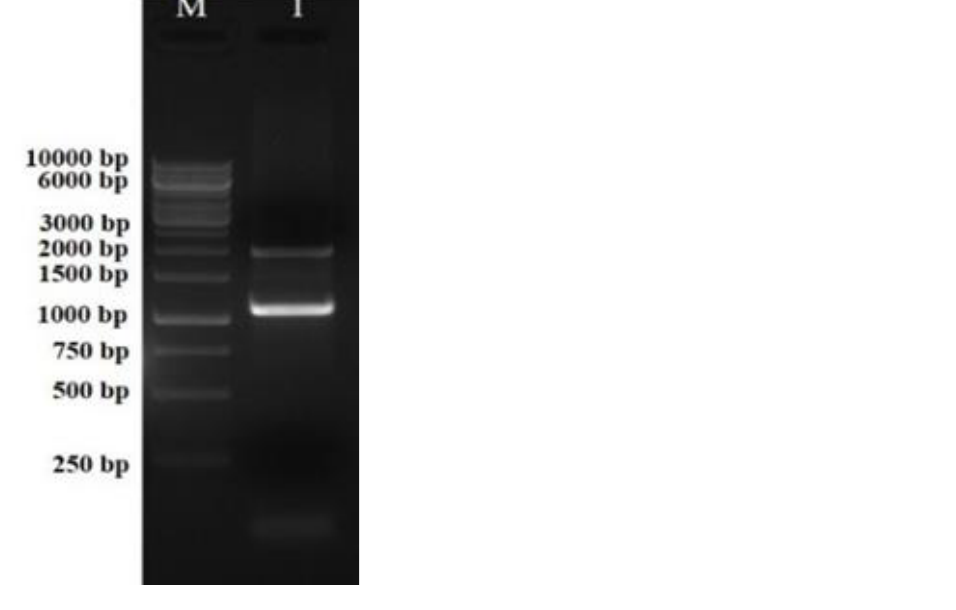
Figure 2. PCR amplification of the phl D gene from genomic DNA of Pseudomonas fluorescens. Lane M: 1 kb DNA ladder; Lane 1: ~1078 kb amplicon of the phl D gene.